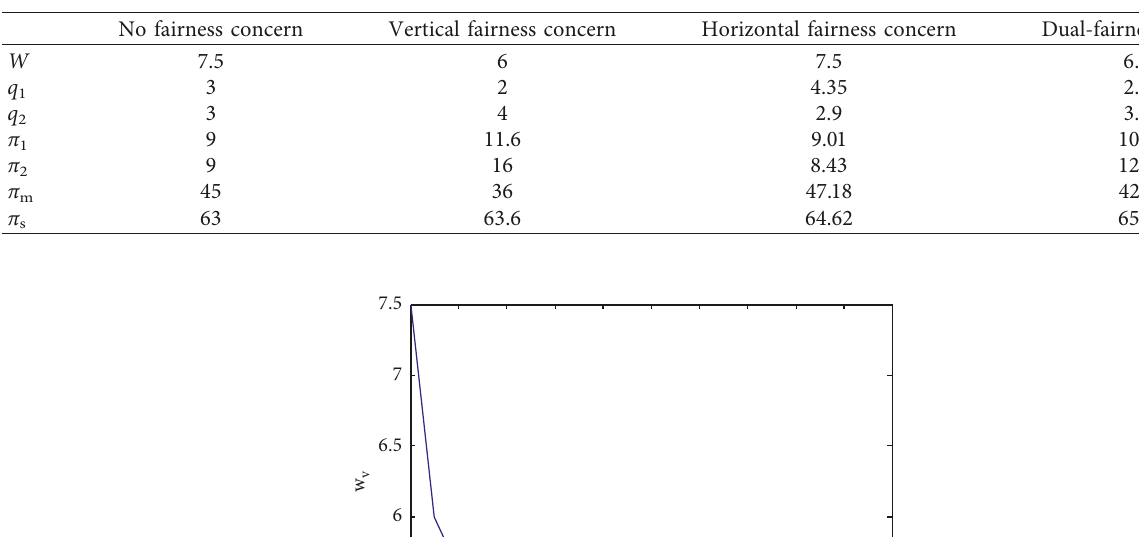
Table 4: Values of supply chain.